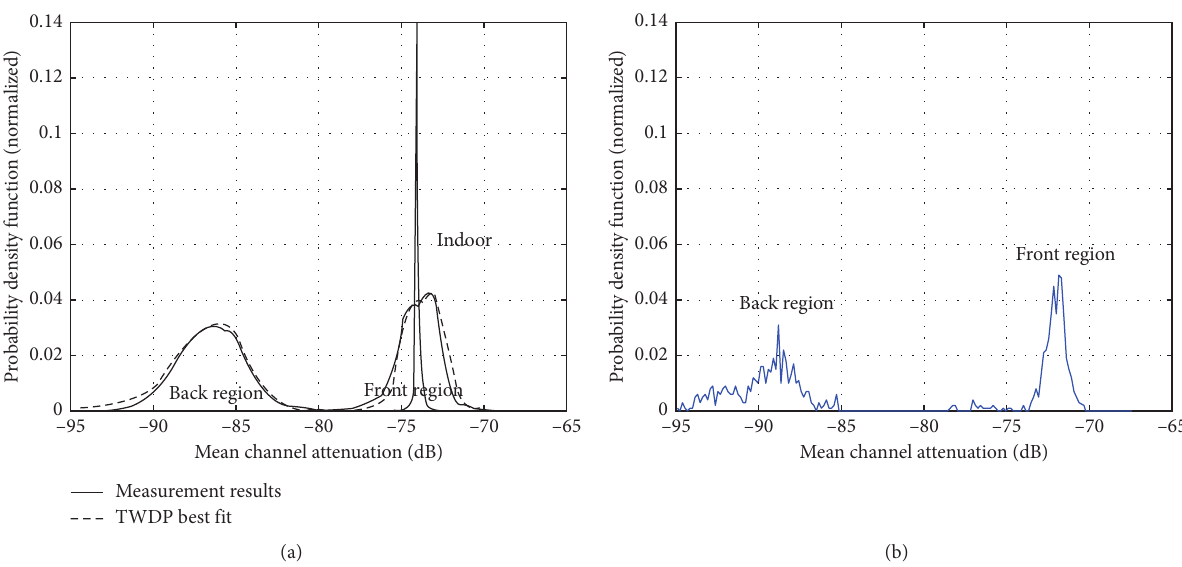
Figure 22: Verification scenario II. (a) Measurement results [27]. The shadowing without the body presence is referred to indoor. (b) Simulation results of front region and back